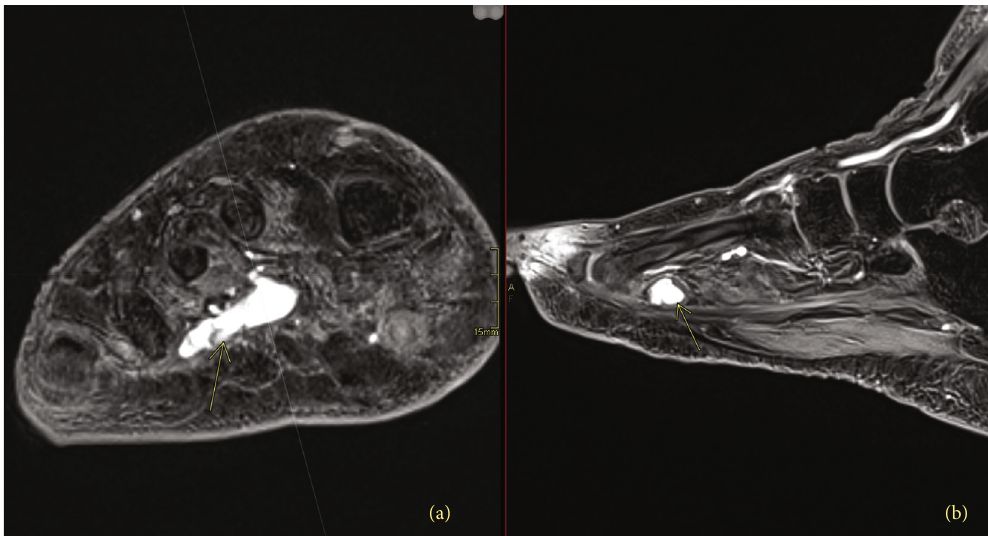
Figure 5: Right foot MRI with contrast for Case 2. Contrast-enhanced axial (a) and sagittal (b) images from an MRI of the foot from patient 2, showing an avidly enhancing soft tissue mass in the plantar aspect of the right midfoot, corresponding to the fi ndings from the DOTATA TE-PET/CT in Figure 4.